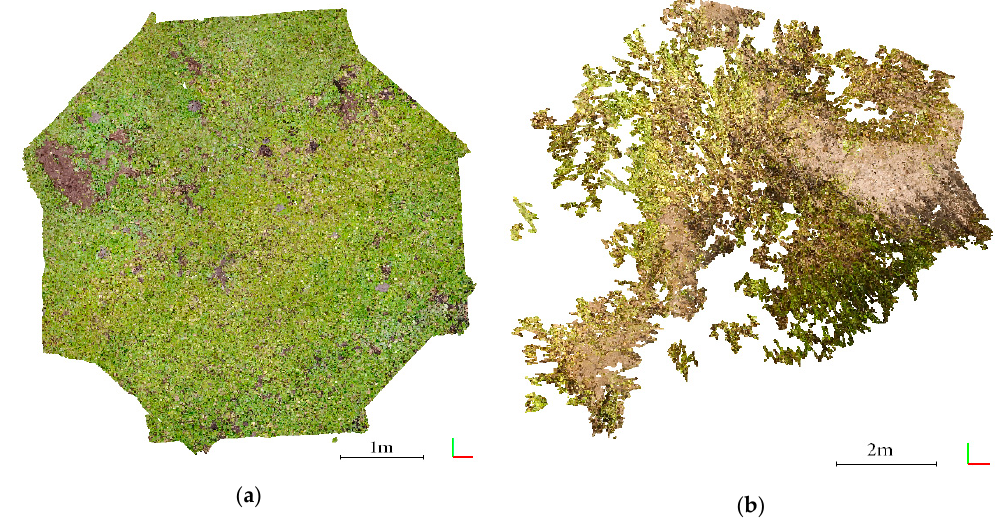
Figure 11. Examples of dense point clouds of grassland generated from UAV photos using the QUADRAT flight mode in the Gansu site ( a ) and Jiangsu site ( b ).